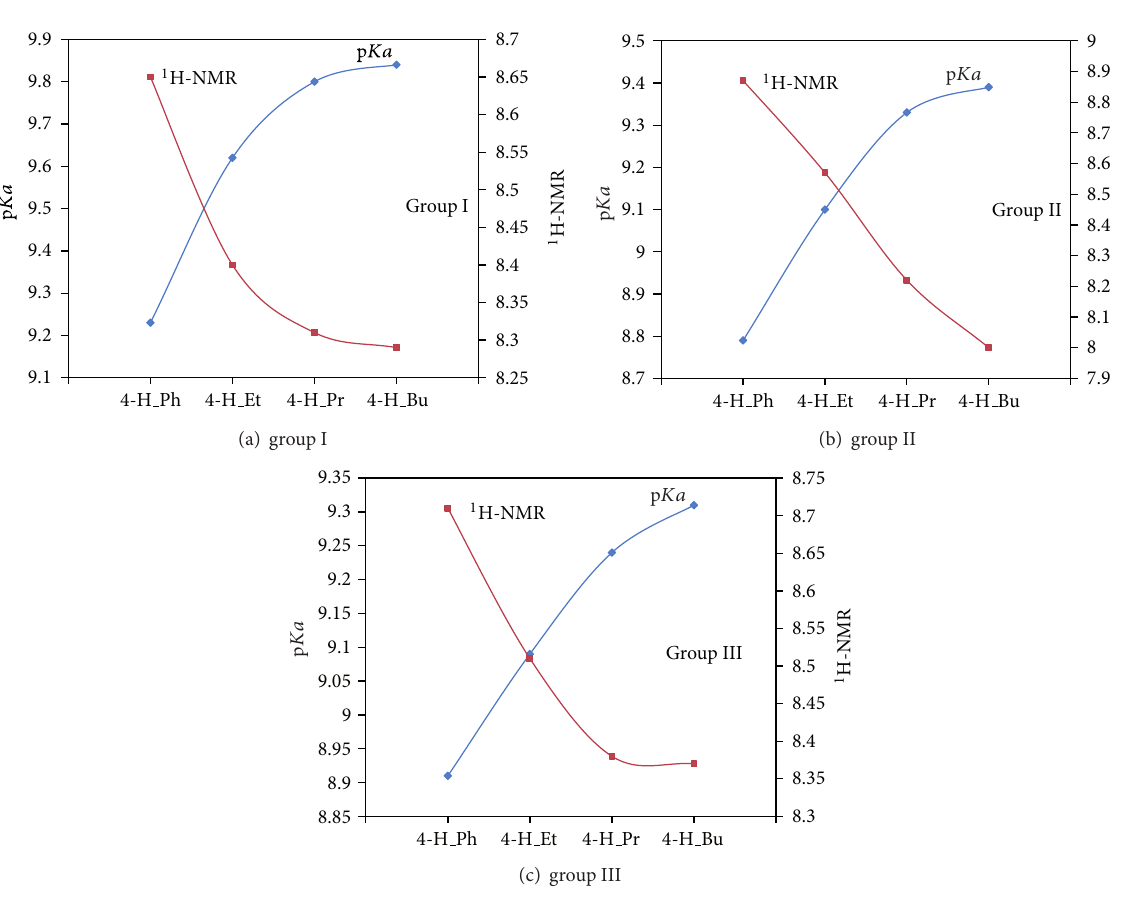
values calculated by using BEST soware and 𝐾𝐾 𝑎𝑎